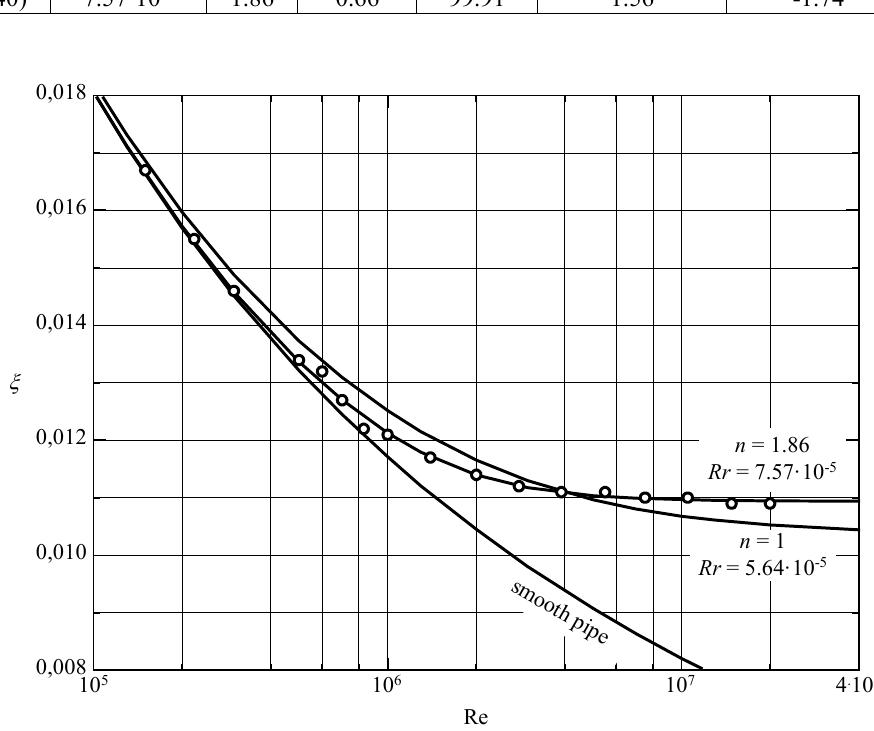
Figure 2 New correlation for friction factor vs. measured data from